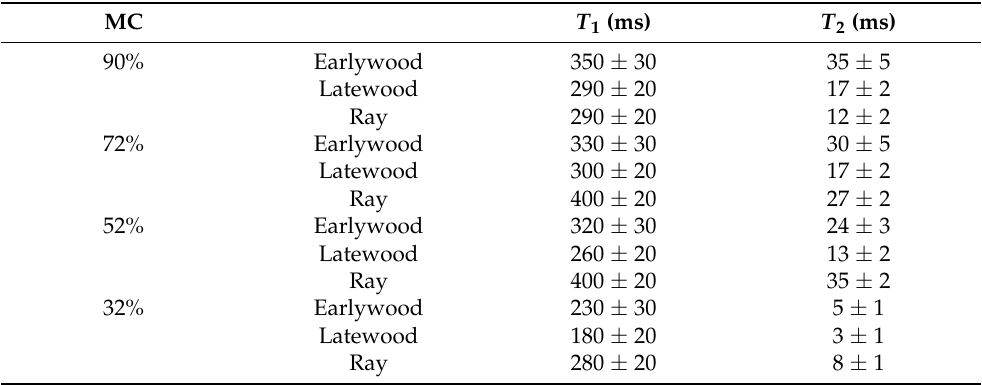
Table 1. T 1 and T 2 values of earlywood, latewood and ray regions obtained from the T 1 and T 2 maps at different